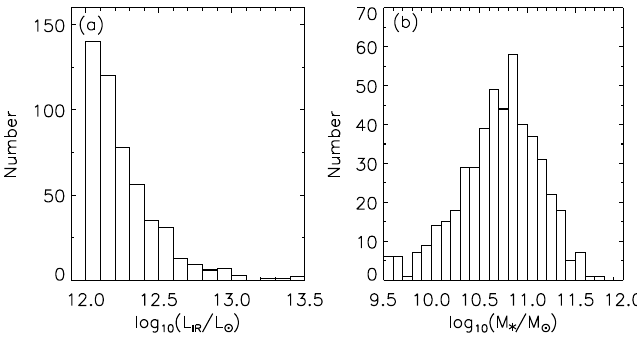
Fig. 1. (a) Distribution of infrared luminosity ( L IR ) of 502 ULIRGs at redshift 1 < z < 3 from the three 3D-HST fields (AEGIS, COSMOS, and GOODS-N). (b) Distribution of stellar mass ( M ∗ ) of ULIRGs in our